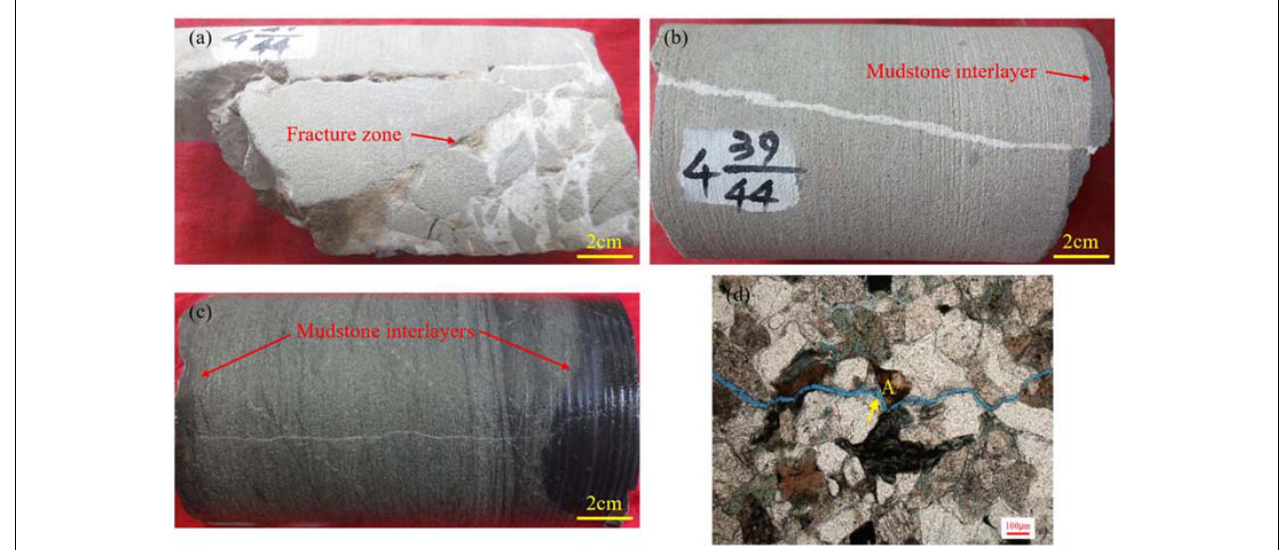
FIGURE 5 | Large-scale fracture, mesoscale fracture, small-scale fracture, and micro-scale fracture in cores and thin sections. (a) Large-scale fracture shows fracture zone, Well N2, depth of 2,309.90 m. (b) Mesoscale fracture cuts mudstone interlayer, Well N2, depth of 2,303.27 m (from Lyu et al., 2016). (c) Small-scale fracture is restricted by mudstone interlayer, Well H4, depth of 2,091.76 m, (d) Micro-scale fracture, Well H3, depth of 2,268.90 m. “A” refers to the micro-scale fracture.